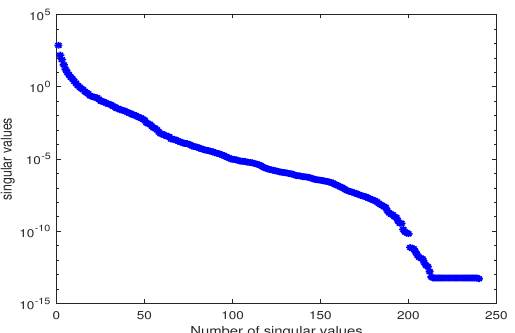
Figure 5. Singular values of the snapshot matrix X for estimating Parameters k s 1 and k s 2 .